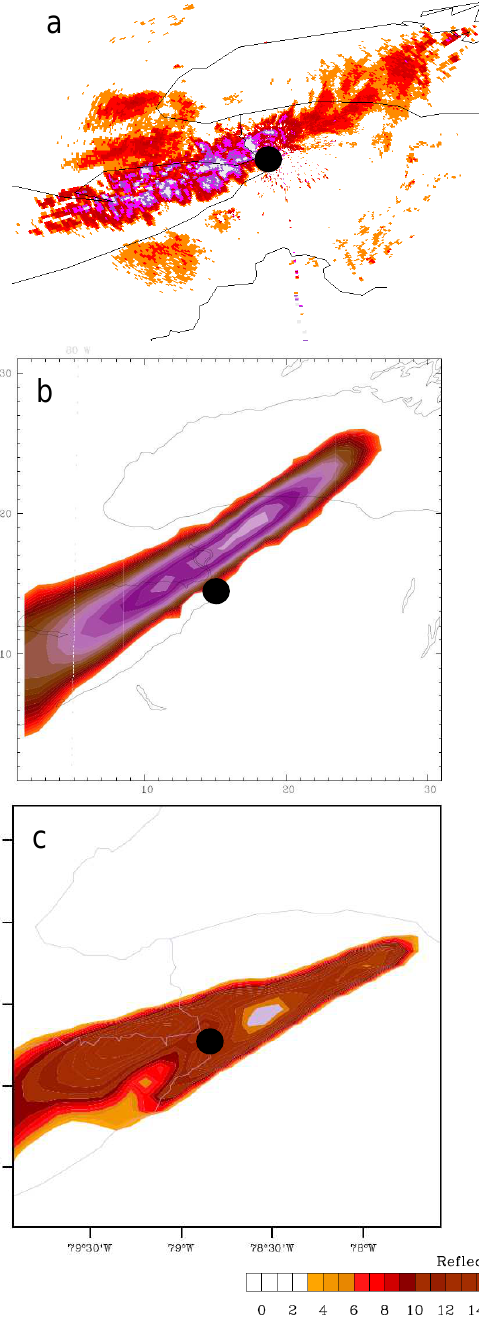
recorded. The observations indicated a maximum precipi- tation of 42.3 mm in 24 h, while MM5 and WRF forecast a maximum precipitation of 18 mm, and 13 mm